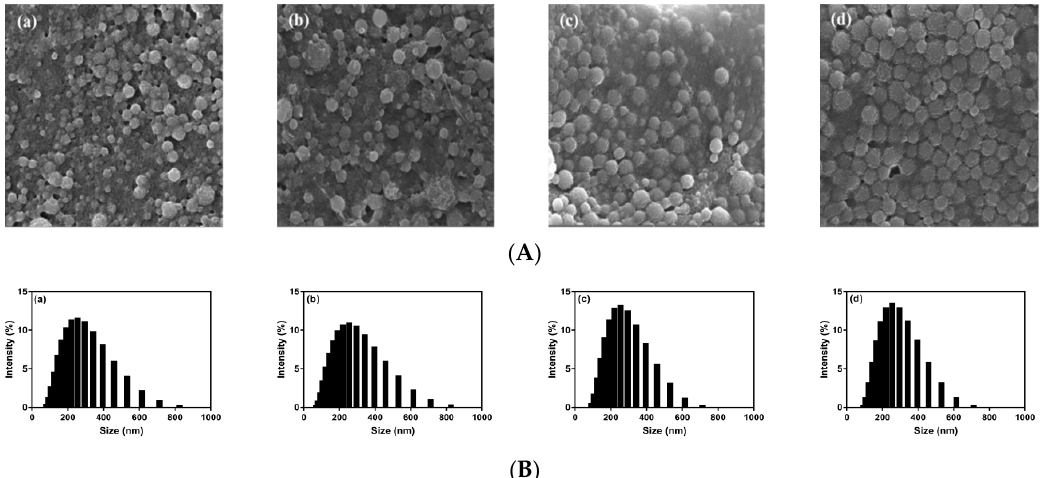
Figure 1. SEM images ( A ) and particle size distributions ( B ) of Res-zein-MSC NPs at zein to Res mass ratios of 10:1 ( a ), 8:1 ( b ), 6:1 ( c ) and 4:1 ( d ), respectively.